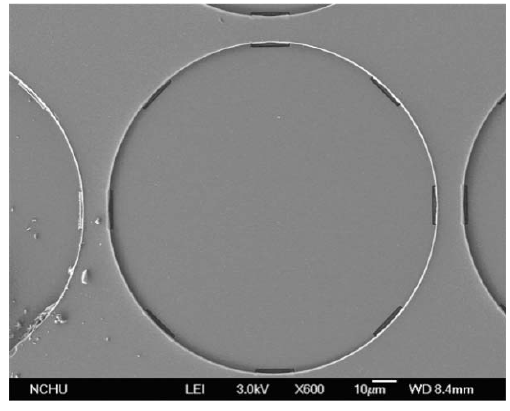
Figure 11. SEM image of a sensing cell after the wet etching